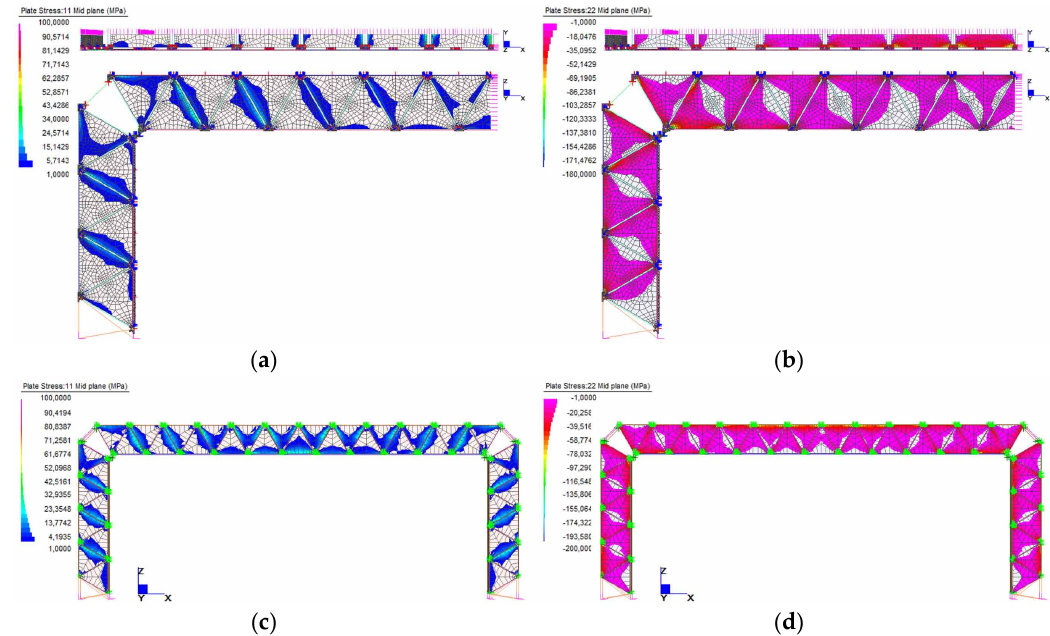
Figure 14. Comparison between the FM TVT γ‐ bis and the CFM TVT γ‐ bis: ( a ) nodal load vs. mid ‐ span deflection; ( b ) nodal load vs. axial force in the lower strand.